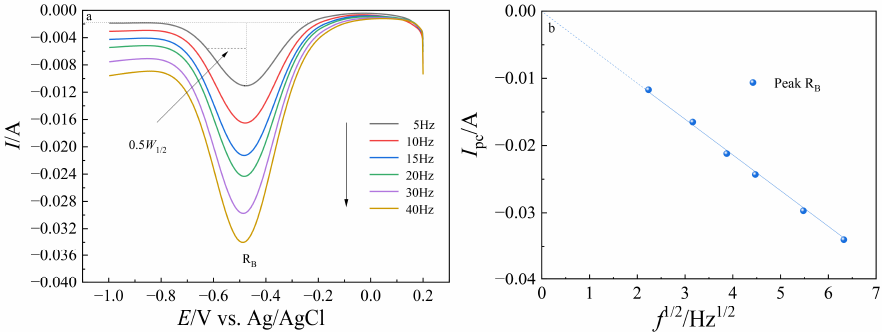
Figure 5. ( a ) SWV curves for the reduction of Yb(III) on the W electrode at 773 K; pulse height: 100 mV; step potential: 5 mV; frequency: 5–40 Hz. ( b ) The linear relationship of I p versus f 1/2 . Table 1. Half-peak width and transfer electron number of Yb(III) calculated on a liquid Pb electrode in molten LiCl-KCl-YbCl 3 under different frequencies.